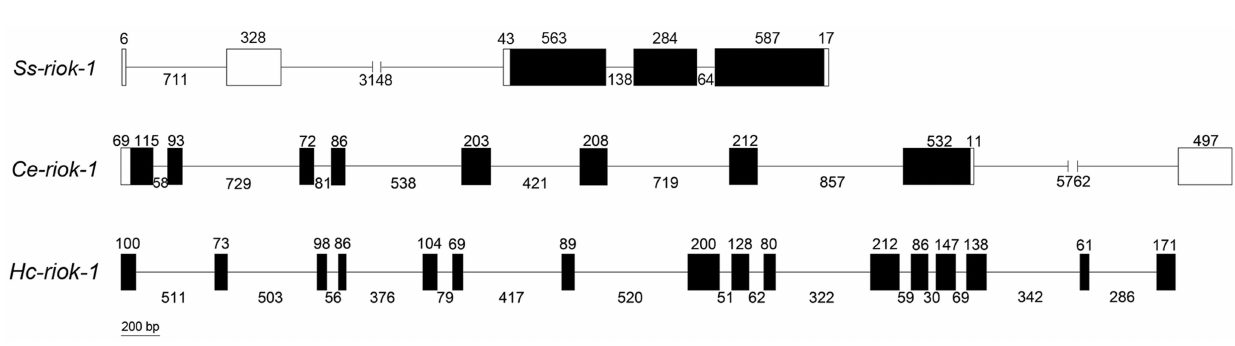
PLOS Neglected Tropical Diseases |